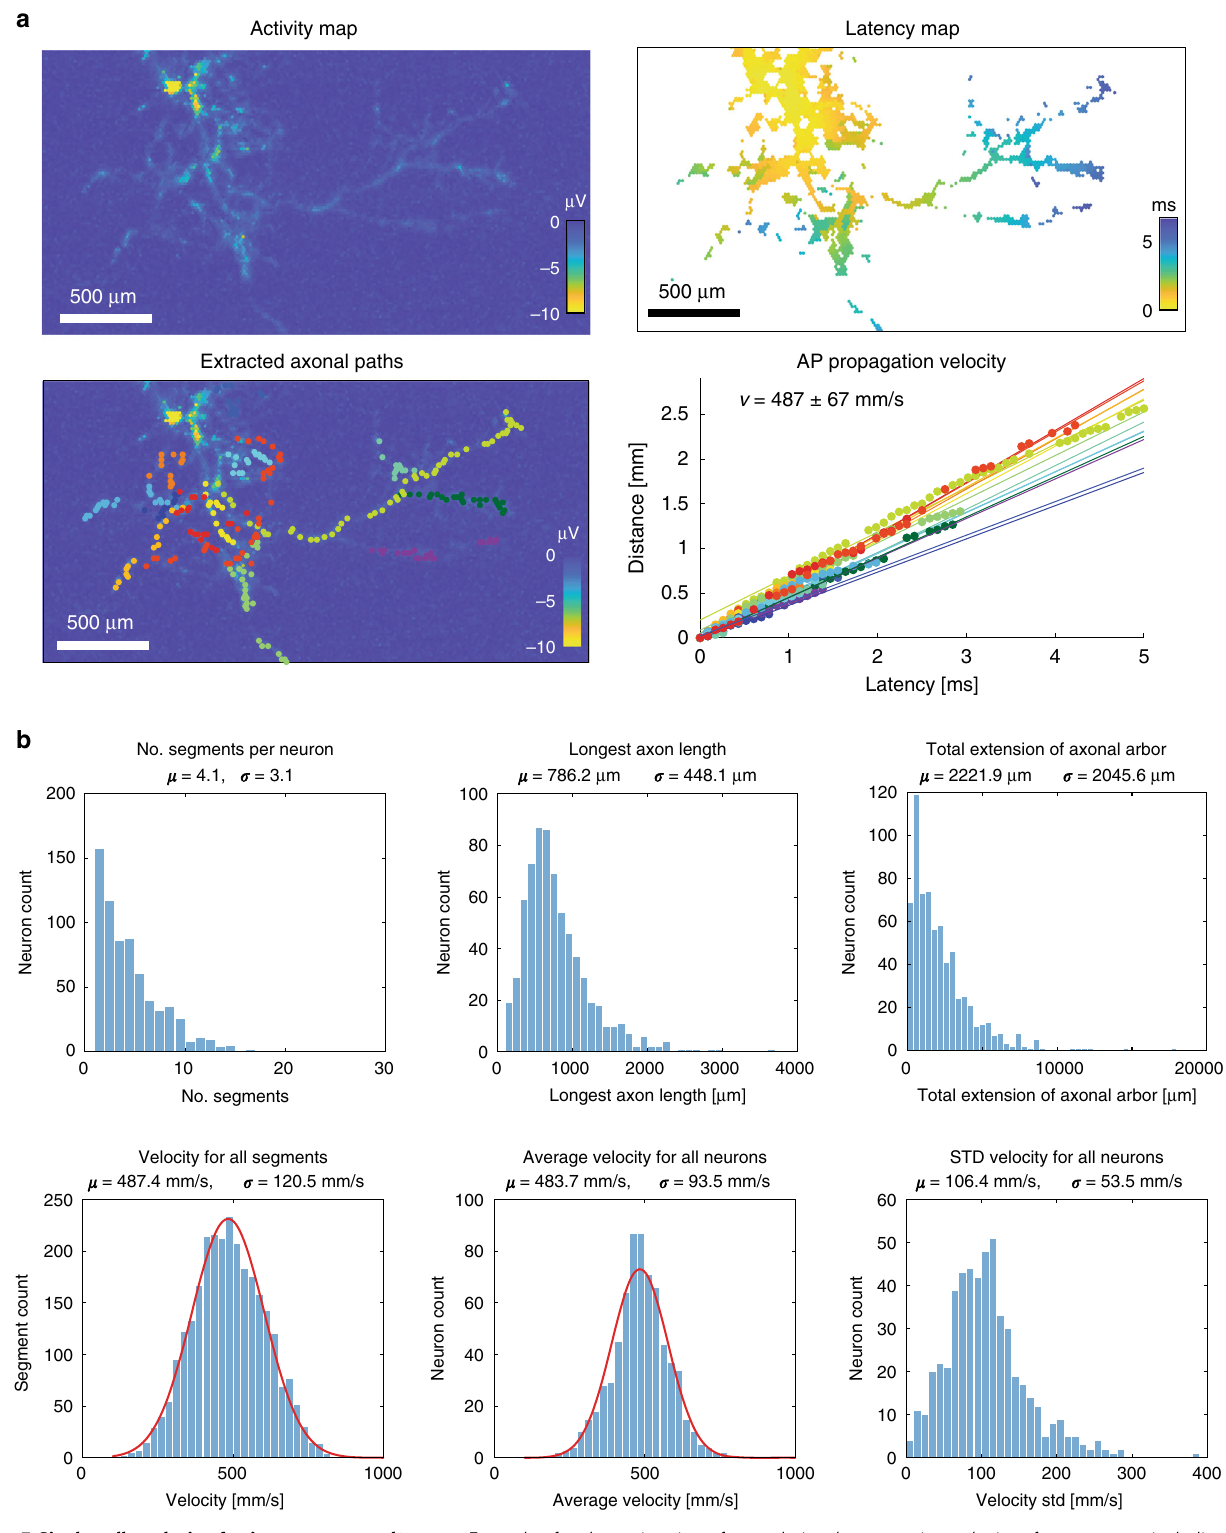
Fig. 5 Single-cell analysis of primary-neuron cultures. a Examples for the estimation of axonal-signal-propagation velocity of one neuron, including amplitude map, latency map, the locations of the selected segments, and a linear fi t to calculate the velocity for each segment. b Single-neuron-derived statistics for these primary cultures ( n = 1086 neurons, data recorded from fi ve cultures on DIV 20), including number of axonal segments, longest axon length (longest selected segments), total extension of axonal arbors (sum of all assigned segments), and action-potential-propagation velocity for all segments, average velocity for all neurons. Mean values ( µ ) are given as well as standard deviations ( σ ). Source data are provided as a Source Data fi